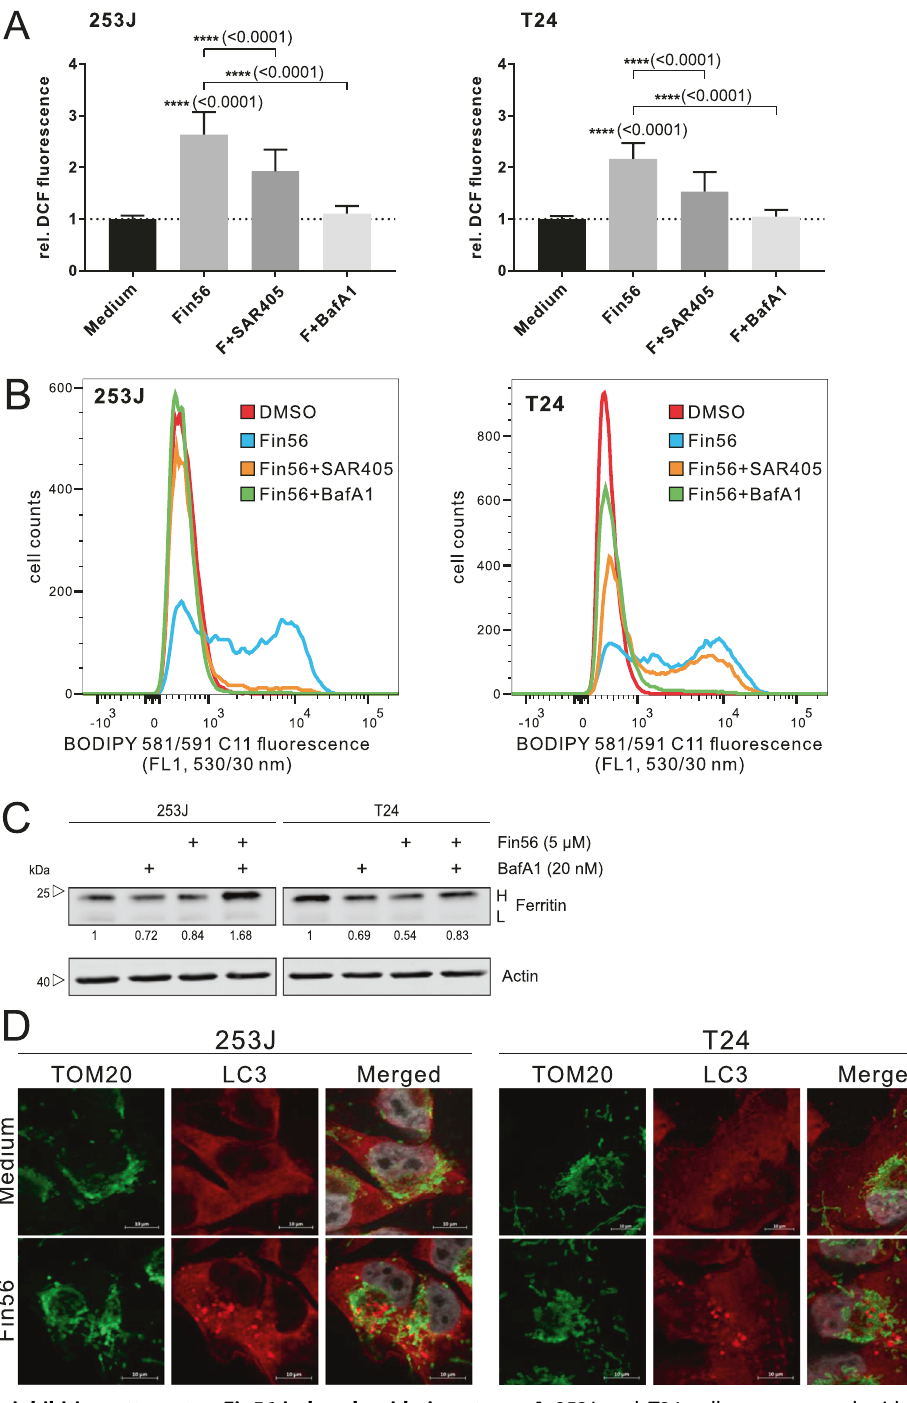
Fig. 5 Autophagy inhibition attenuates Fin56-induced oxidative stress. A 253J and T24 cells were treated with Fin56 (2 µM), Fin56 + SAR405 (2 µM) or Fin56 + BafA1 (20 nM) for 4 h. After treatment, cells were treated with 10 μ M H 2 DCFDA for 30 min. After that, DCF fl uorescence was measured. Results are shown as means + SD of three independent experiments performed in triplicates for each treatment. P values were determined by one-way ANOVA with Tukey´s post hoc test. The respective P values are depicted in the diagram. B 253J and T24 cells were treated with DMSO, Fin56 (2 µM), Fin56 + SAR405 (2 µM) or Fin56 + BafA1 (20 nM) for 4 h. Then, cells were incubated with 1.5 µM BODIPY 581/591 C11 for 30 min at 37 °C before they were harvested by trypsinisation. Subsequently, cells were resuspended in 500 μ L PBS and analyzed by fl ow cytometry. Data were collected using the FL1 detector with a 530/30 BP fi lter. A total of 20,000 events was acquired for each sample. C 253J and T24 cells were treated with Fin56 (5 µM), BafA1 (20 nM), or Fin56 + BafA1 for 4 h. After the incubation, cells were lysed and cellular lysates were immunoblotted for the indicated proteins (H, heavy chain; L, light chain). One representative immunoblot is shown. The quanti fi cations are from two independent experiments. D 253J and T24 cells were grown on glass coverslips one day prior to treatment. The following day, cells were treated with 5 µM Fin56 for 6 h. After treatment, cells were fi xed, permeabilized, and incubated with indicated antibodies. Nuclei were stained with DAPI. One representative image is